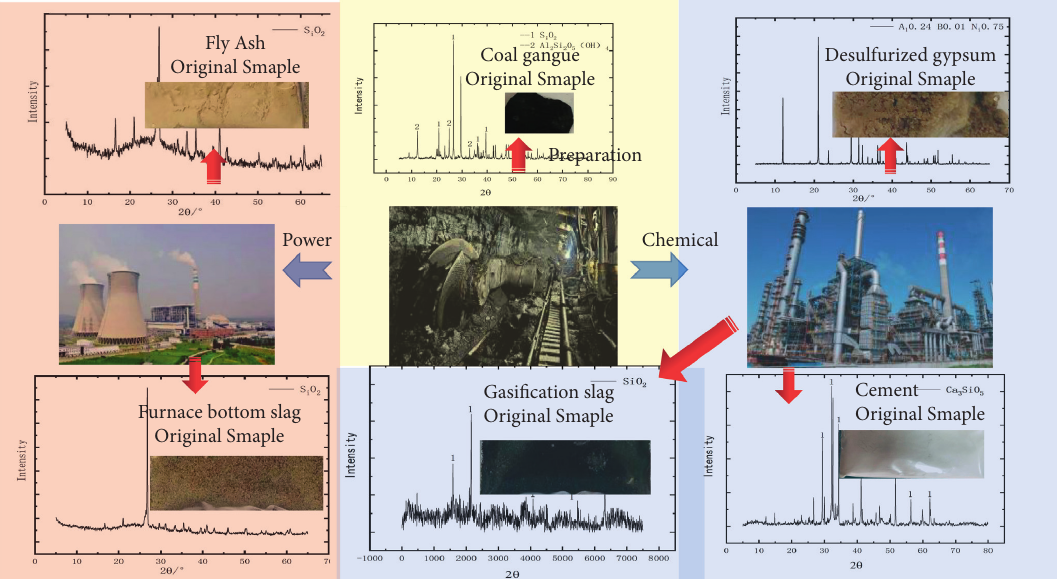
Figure 2: XRD spectra of five solid wastes in the Ningdong mining area.